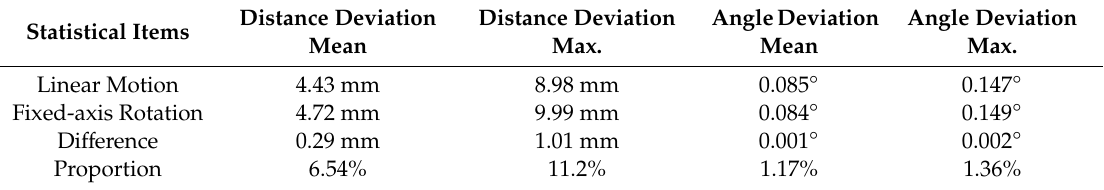
Table 6. Comparison between the linear motion and the fixed-axis